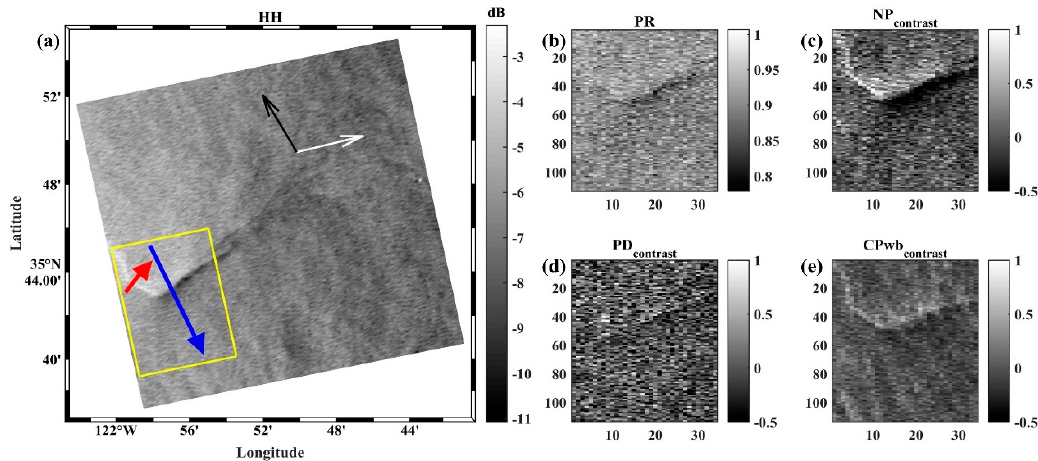
Figure 9. SAR images containing ocean current feature: ( a ) RS-2 SAR HH-polarized images (dB units) of an area of the West Coast of USA acquired at 01:57 UTC on August 9, 2009. The key parameters associated with the enlarged region of the yellow fragment in ( a ) are estimated as: ( b ) PR (linear units); ( c ) NP contrast; ( d ) PD contrast, and ( e ) CPwb contrast. The incidence angle, averaged wind speed and the angle between radar look direction and wind direction are about 23 degrees, 12 m / s and 108 degrees, respectively. RS-2 data are a product of MacDonald, Dettwiler, and Associates, Ltd. All rights reserved.